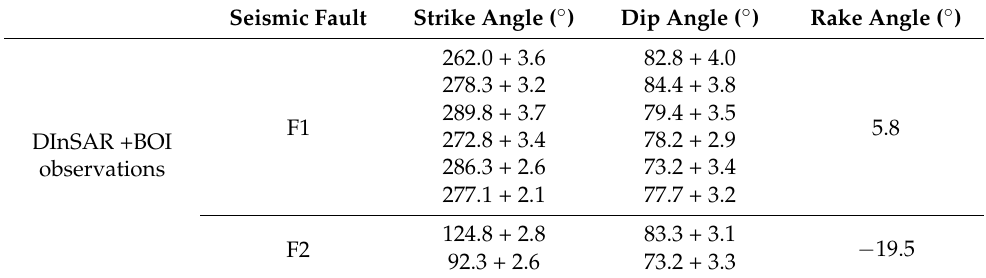
Table 5. Fault parameters of the 2021 Maduo earthquake solved by DInSAR and BOI observations.